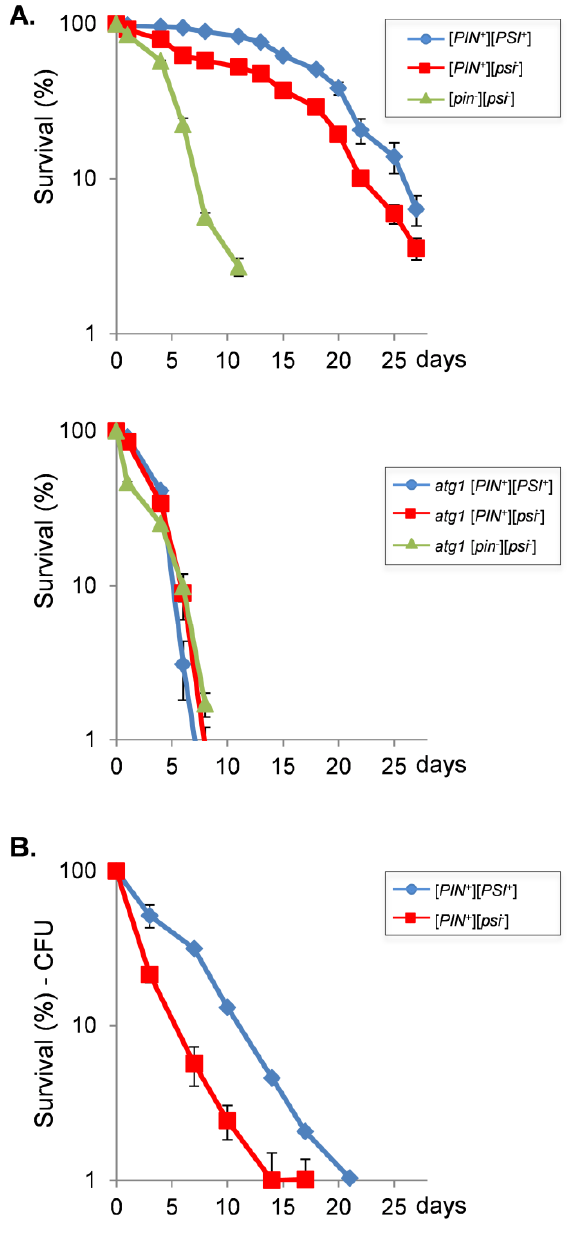
FIGURE 2: Prions improve chronological lifespan. (A) Chronologi- cal lifespan analysis, as determined by propidium iodide uptake to assess yeast cell death, is shown for [ PIN + ][ PSI + ], [ PIN + ][ psi - ] and cured [ pin - ][ psi - ] versions of wild-type and atg1 mutant strains . Cells were grown in SCD media for 3 days to reach stationary phase and then aliquots taken every 2-3 days for flow cytometry analysis based on propidium iodide uptake by non-viable cells as assayed through flow cytometry. Data shown are the means of at least three independent biological repeat experiments expressed as the percentage of viable cells out of 10000 cells analyzed. Error bars denote standard deviation. (B) Viability measurements are shown for [ PIN + ][ PSI + ] and [ PIN + ][ psi - ] strains grown under the same conditions as for (A) above. Viability is expressed as a per- centage of day